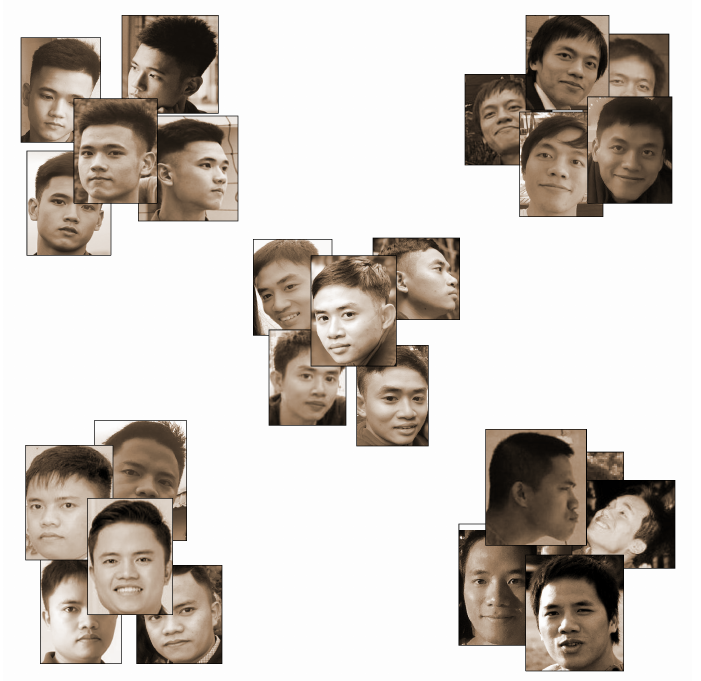
Figure 3. Sample face images from the self-collected HMTA dataset for face